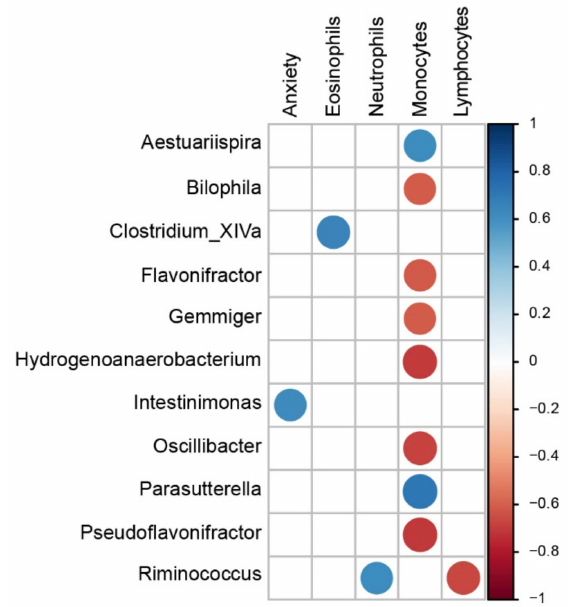
Figure 9. Pathological connection between modifications observed after NIMP exposure. Identi- fication of bacterial genera found associated with host anxiety status and blood mononuclear cell abundance. Spearman correlations were computed using the genus abundance table and host meta- data. Displayed correlations were all significant ( p ≤ 0.05) and lower than − 0.6 or higher than 0.6. Anxiety: cumulative open area activity (%), Eosinophils (%), Neutrophils (%), Monocytes (%) and Lymphocytes